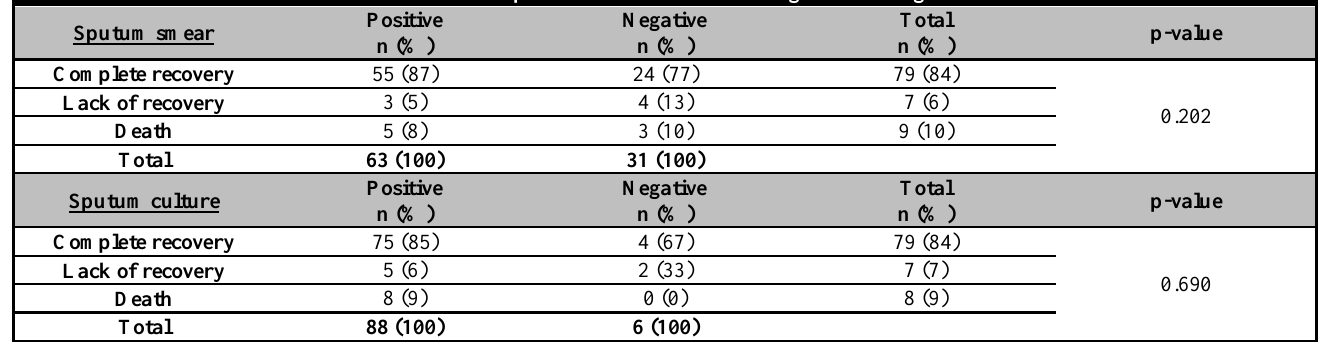
Table 2. Response to treatment based on gender and age